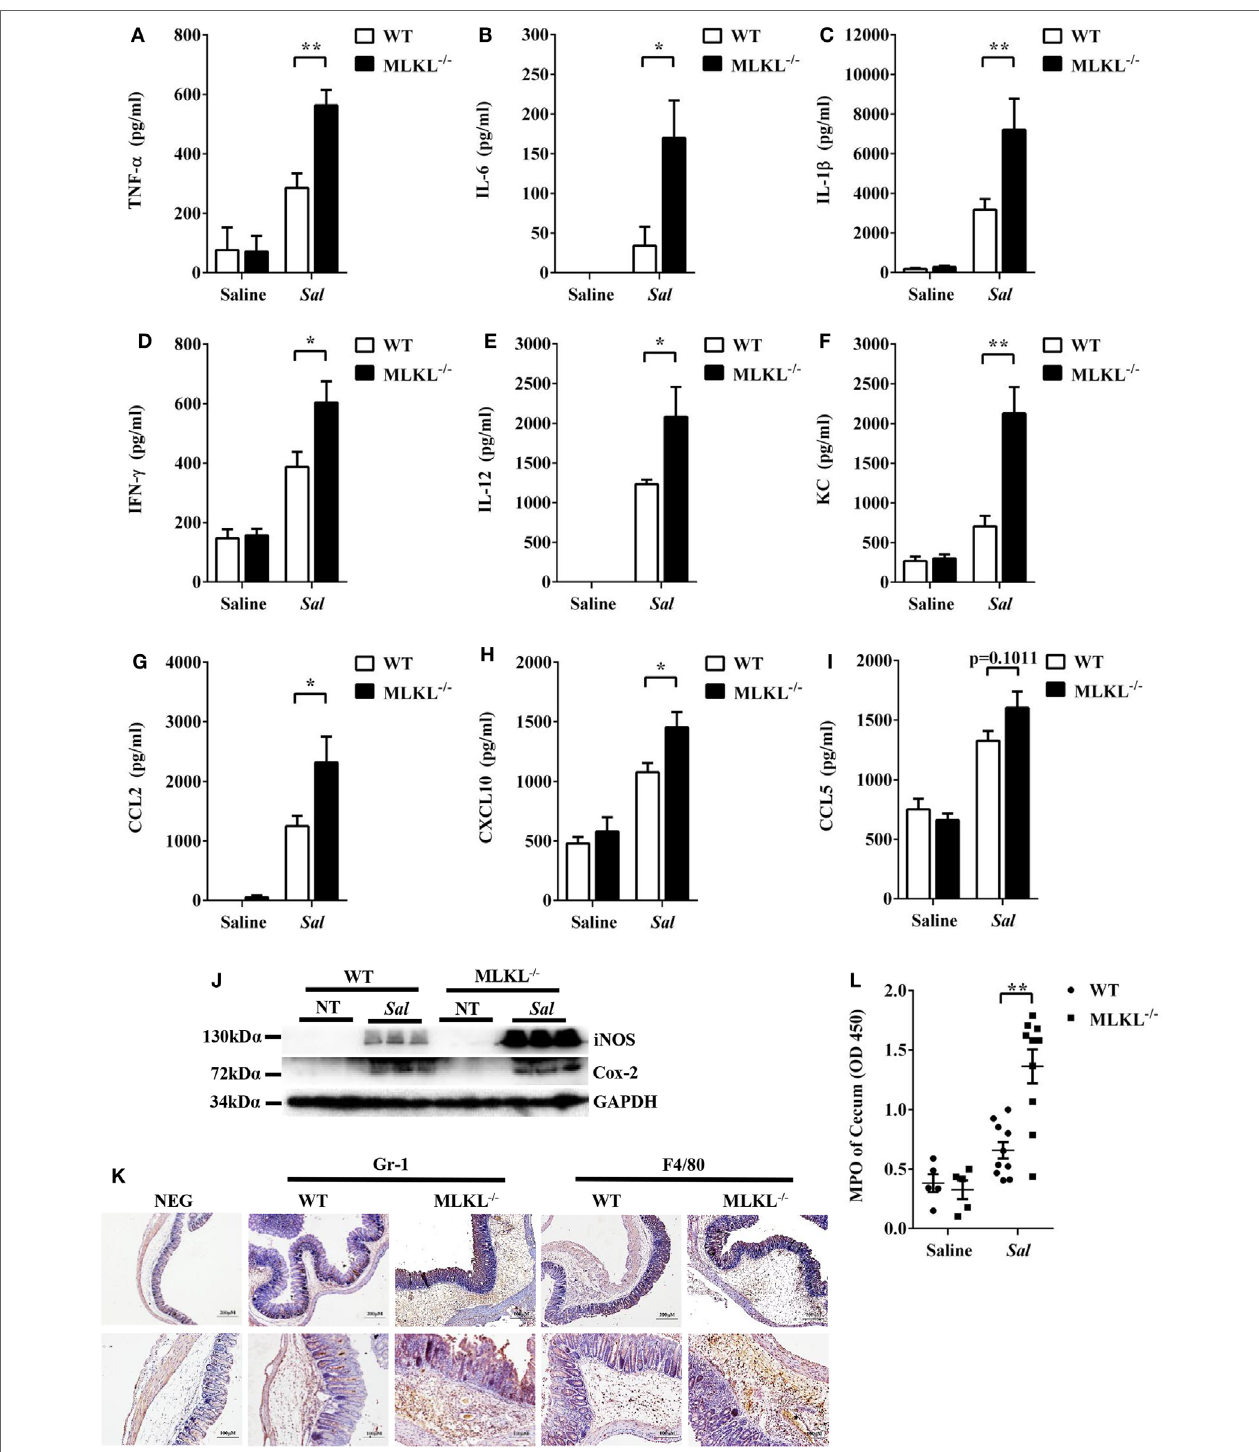
FigUre 2 | MLKL deficiency leads to enhanced pro-inflammatory mediator production following Salmonella intestinal infection. Streptomycin-pretreated WT and MLKL − / − mice were orally infected with Salmonella (5 × 10 7 CFU, n = 10 each group) for 48 h. The homogenate supernatant of cecum was detected for concentrations of indicated cytokines and chemokines by ELISA. (a) TNF- α , (B) IL-6, (c) IL-1 β , (D) IFN- γ , (e) IL-12, (F) KC, (g) CCL2, (h) CXCL10, (i) CCL5. (J) Representative cecum tissue lysate was analyzed for iNOS and Cox-2 by western blotting. GAPDH was used as a loading control. (K) Representative immunohistochemical staining of Gr-1 (a neutrophil marker) and F4/80 (a macrophagocyte marker) were performed in the cecal sections. (l) The homogenate supernatant of cecum was also used to determine activity of MPO (a neutrophil marker). All data are shown as mean ± SEM. Student’s t -test was performed. Statistical significance is indicated by * p < 0.05, ** p <